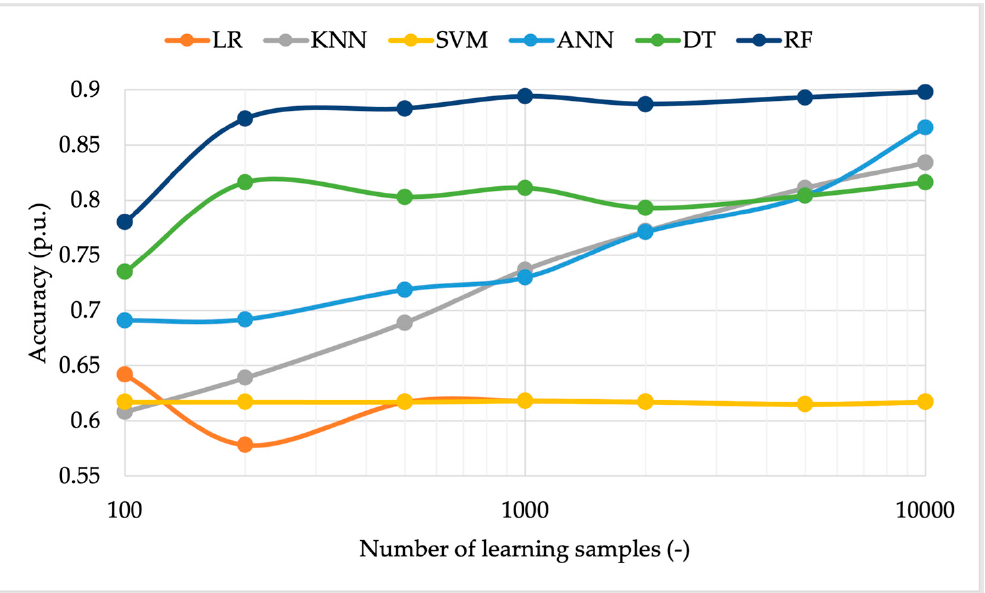
Figure 6. Algorithm accuracy vs. the number of learning samples using uniform distributed inputs.